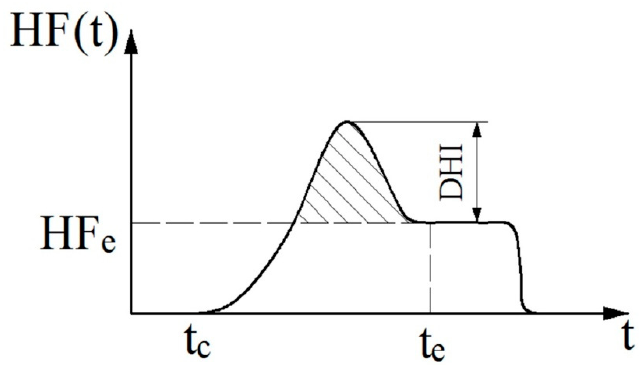
Figure 9. Typical curve of heat flow during the measurement process, HF( t ): heat flux signal vs. time; HF e : average heat flux at equilibrium status; DHI: difference between dynamic heat flow ad heat transfer at equilibrium status; t c : time when the upper measuring head just contacts the sample and heat begins to transfer; t e : time when the heat transfer has just reached equilibrium status.